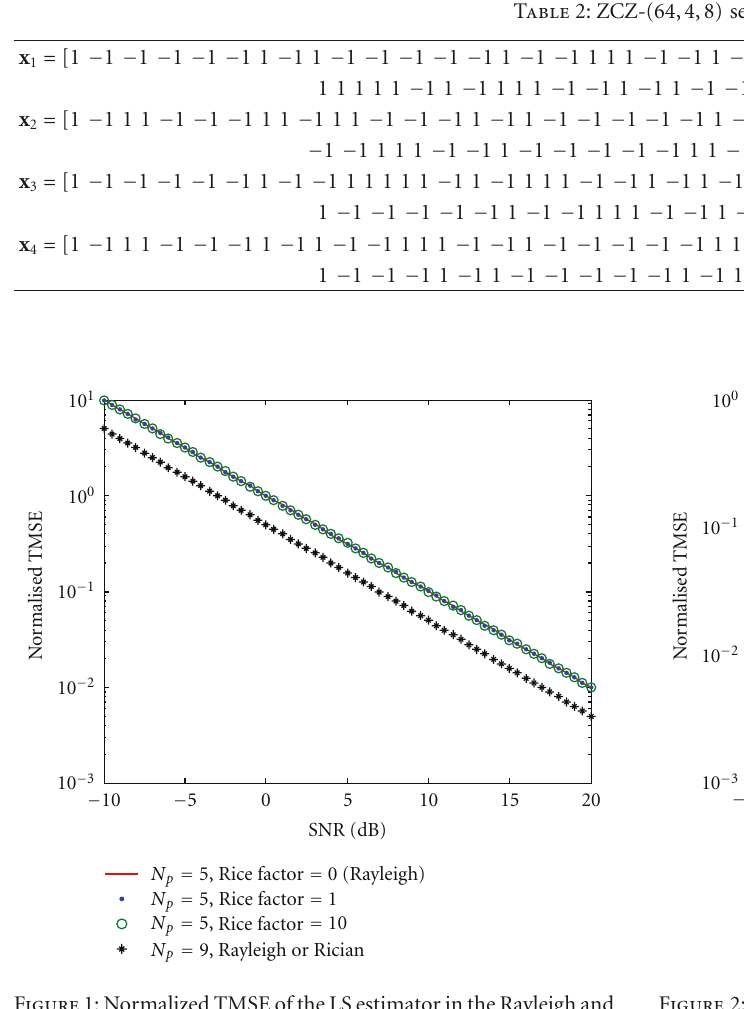
Figure 1: Normalized TMSE of the LS estimator in the Rayleigh and Rician fading channels ( N T = N R = 2, L = 1, N P = 5,9).